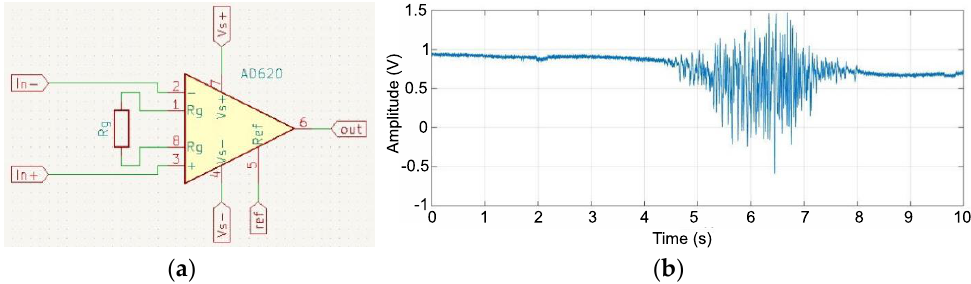
Figure 3. Scheme of connection of the instrumental amplifier circuit model AD620 ( a ), EMG biceps brachii signal amplified 495 times by the instrumental amplifier AD620ARZ ( b ).